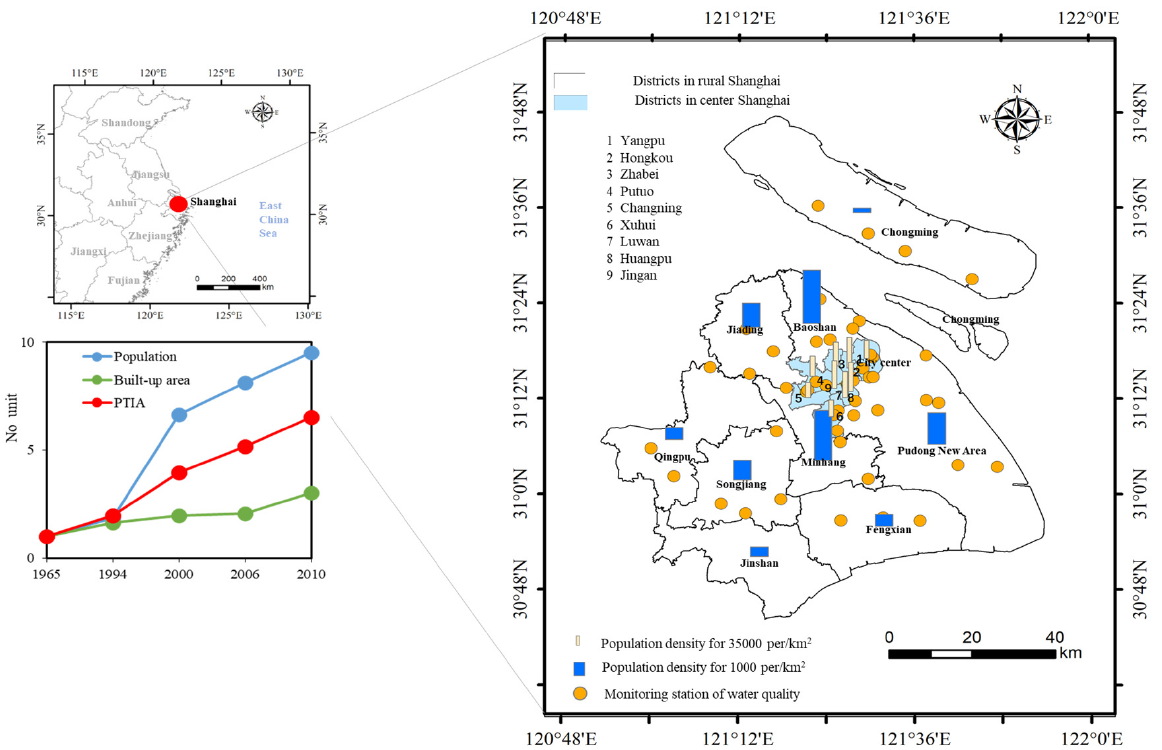
Figure 1. Location and the spatial distribution of population density in the city center and suburbs of Shanghai including the changes of population, built-up area and PTIA (each year’s value of population, built-up area and PTIA divided by the data of 1965) and monitoring station of water quality.